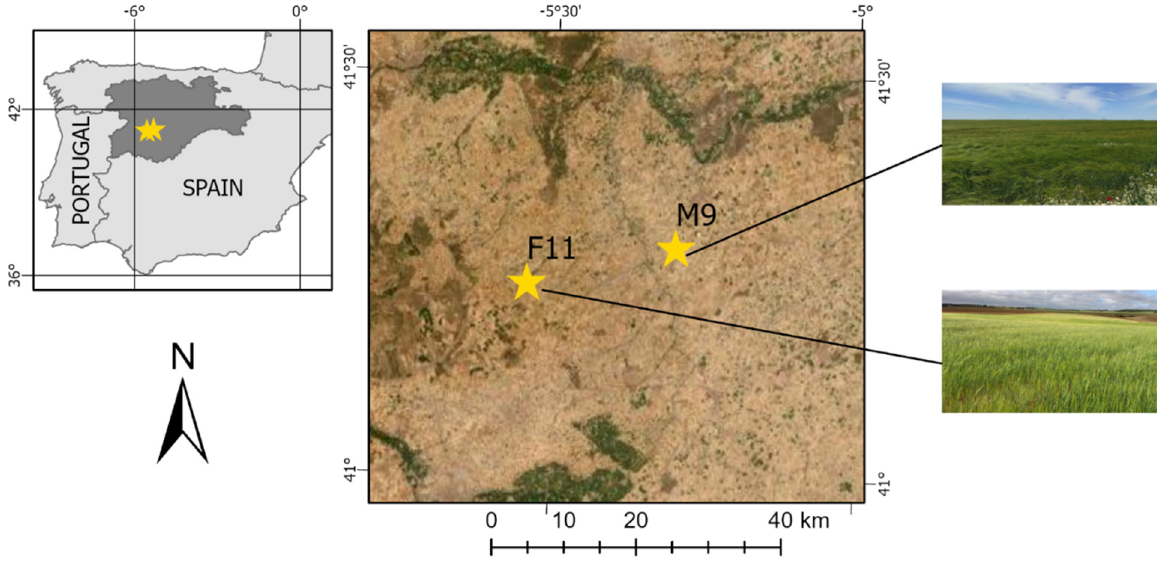
Figure 1. Location of F11 and M9 plots.